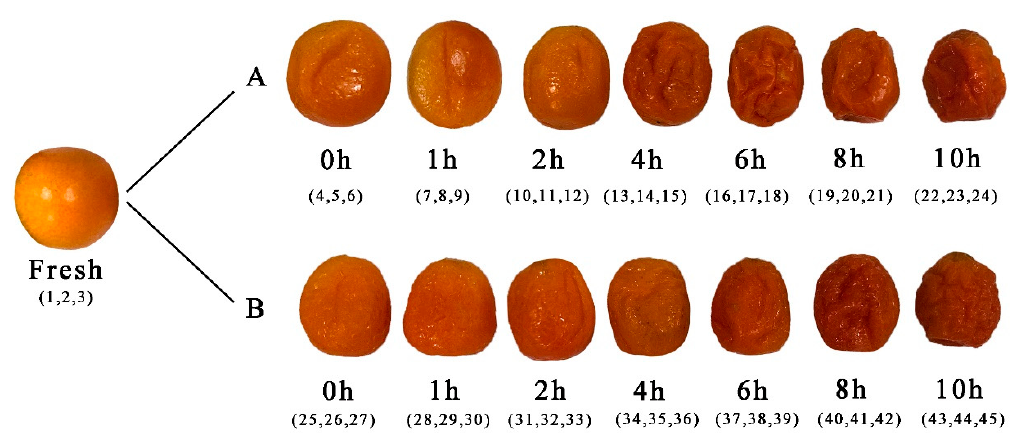
Figure 9. FKs, VS-ADKs ( A ), and AS-ADKs ( B ).